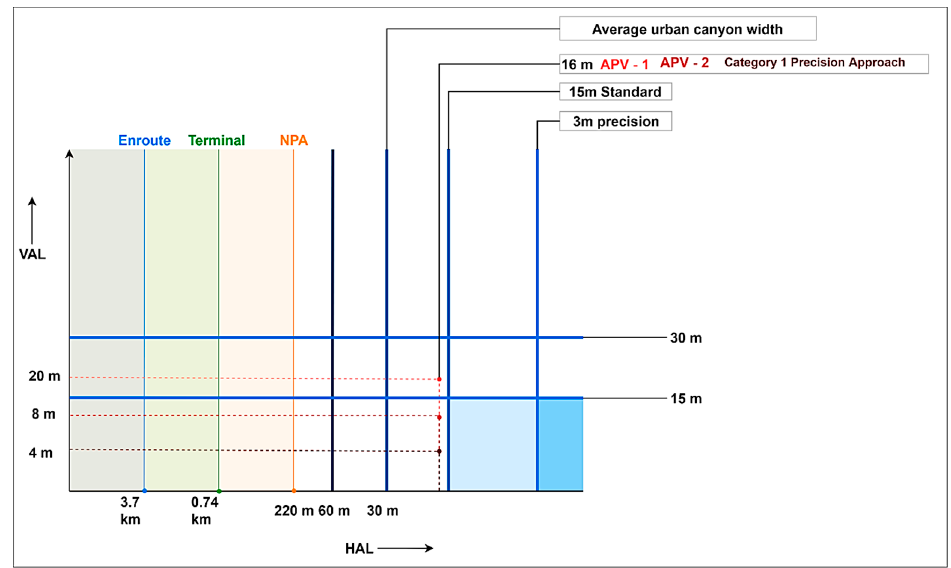
Figure 3. Alert limits for manned aircraft and preliminary PBN bounds for UAS.